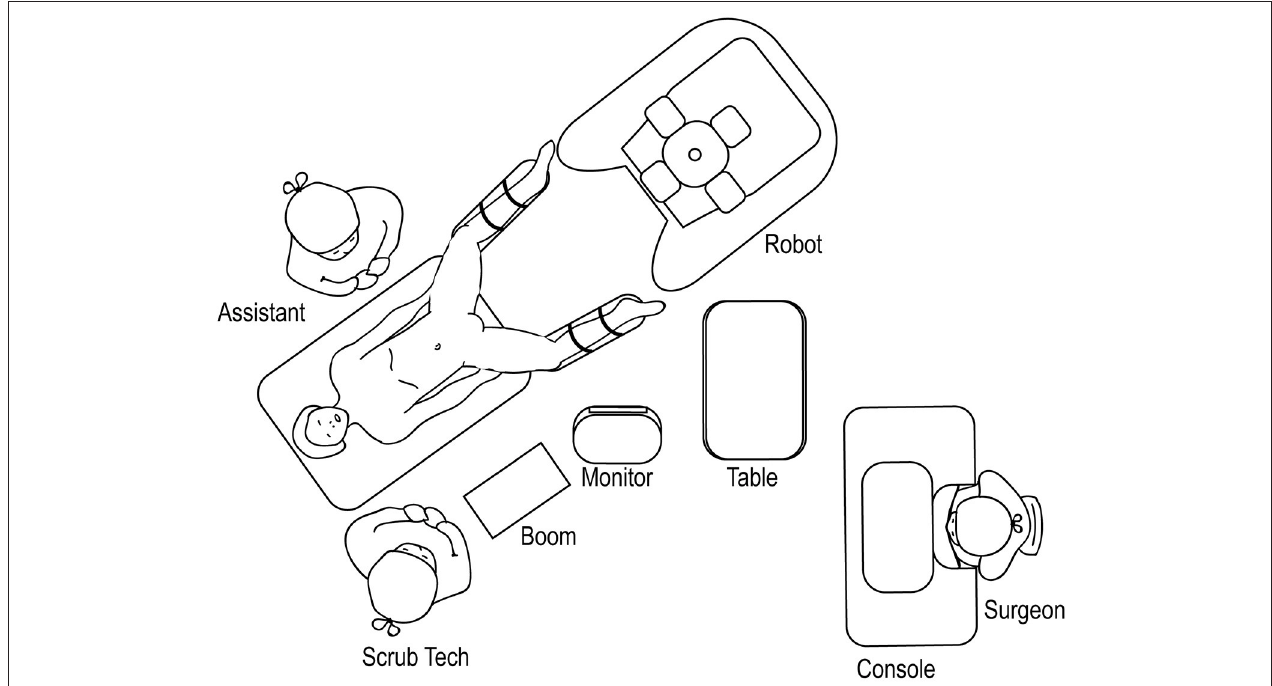
FIGURE 14 | Overhead view of room set-up for lower urinary tract surgery in the lithotomy or frog-leg supine positions.